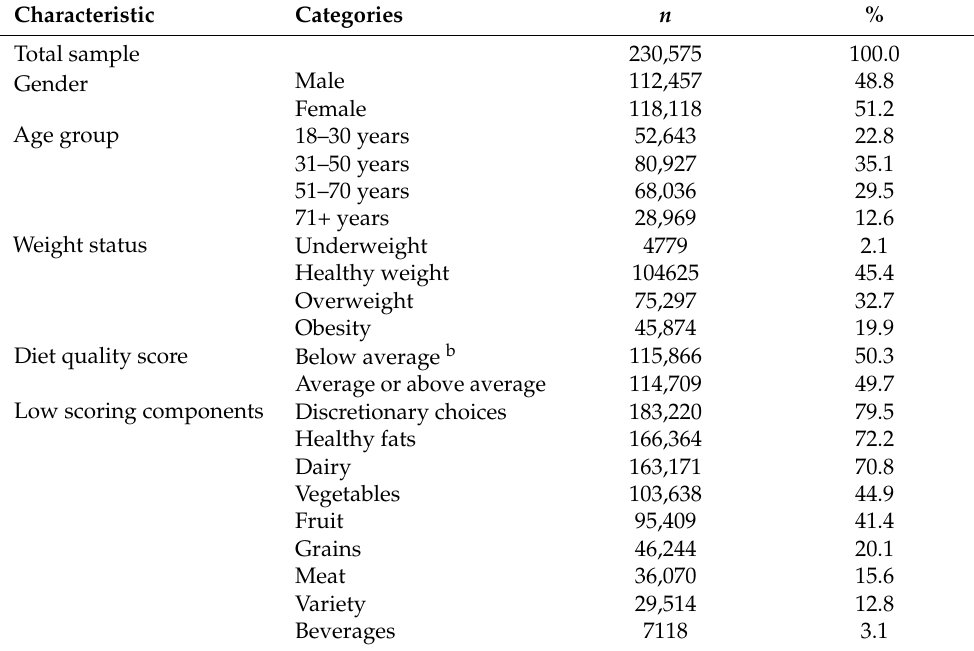
Table 2. Demographics, weight status, diet quality characteristics and frequency of low scores for the dietary guideline index components in a sample of 230,575 Australian adults a